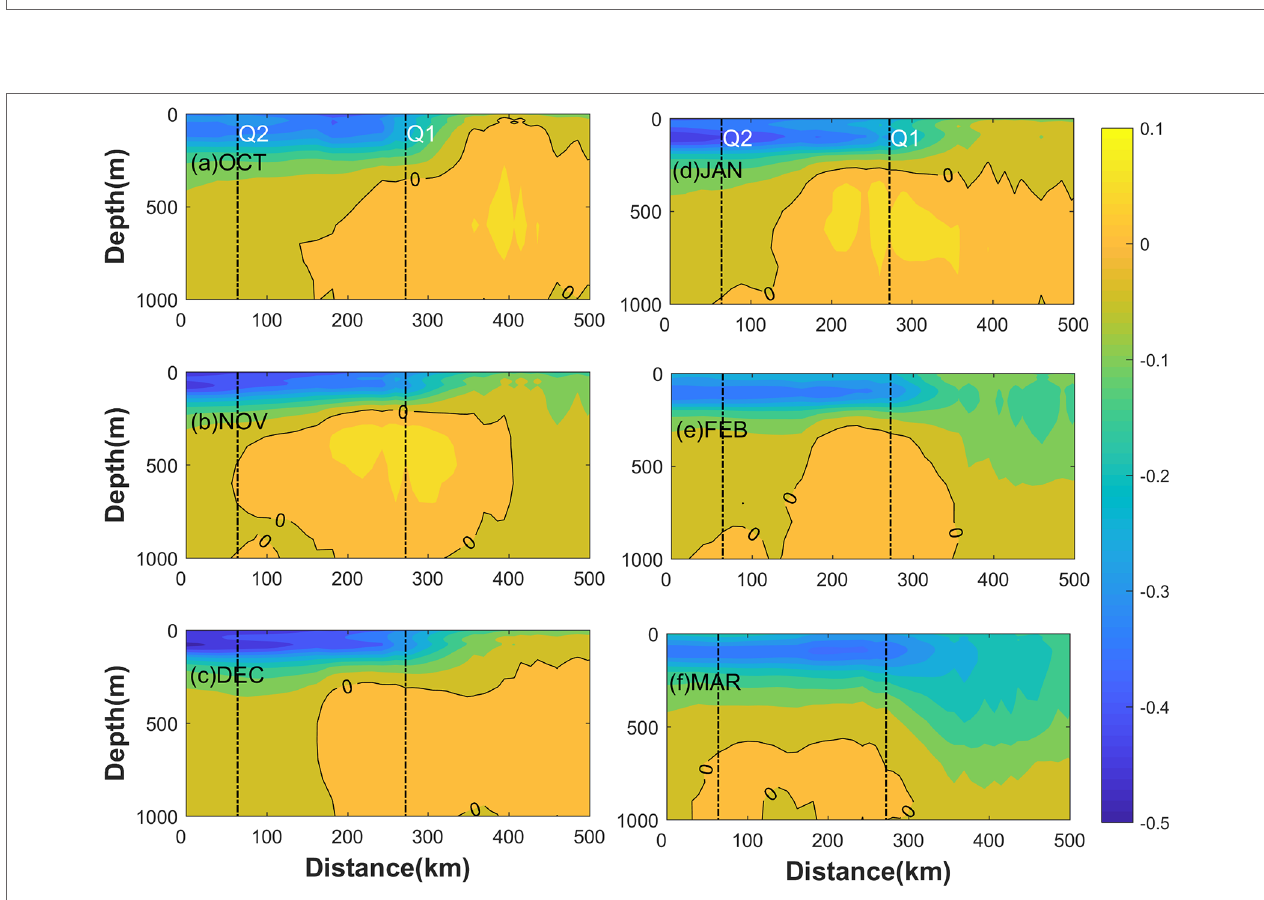
FIGURE 8 | The 10-yr mean along-slope current (m/s) from HYCOM output along the 1000-m isobath in the months of winter monsoon: Oct. (A) , Nov. (B) , Dec. (C) , Jan. (D) , Feb. (E) and Mar. (F) . The black contours indicate zero flow speed. The along-isobath distances of mooring stations Q1 and Q2 are indicated with black dotted